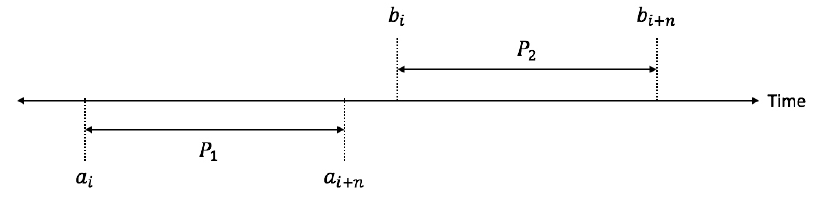
Figure 1. Time of the day in which P 1 and P 2 use the parking. a i , b i and a ( i + n ) , b ( i + n ) are the arrival, respectively, the departure time of the